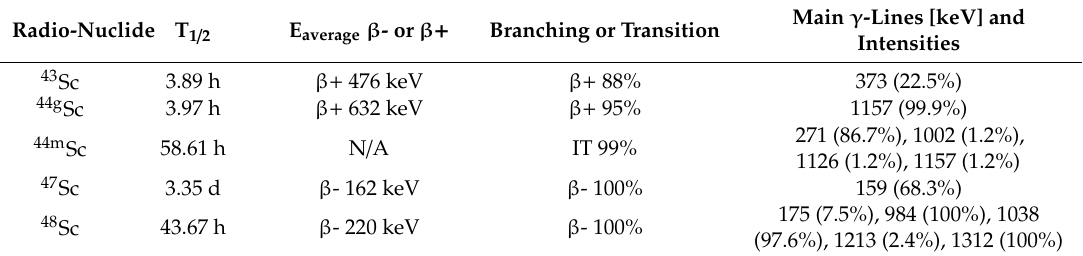
Table 1. Nuclear data [18] of medically interesting scandium radioisotopes ( 43 Sc, 44g / m Sc, 47 Sc). 48 Sc, as a radioactive impurity, is also listed here with reference to the analysis in this paper. Radio-Nuclide T 1 / 2 E average β - or β + Branching or Transition 43 Sc 3.89 h β + 476 keV β + 88% 373 (22.5%) 44g Sc 3.97 h β + 632 keV β + 95% 1157 (99.9%) 44m Sc 58.61 h N / A IT 99% 271 (86.7%), 1002 (1.2%), 47 Sc 3.35 d β - 162 keV β - 100% 159 (68.3%) 48 Sc 43.67 h β - 220 keV β - 100% 175 (7.5%), 984 (100%), 1038